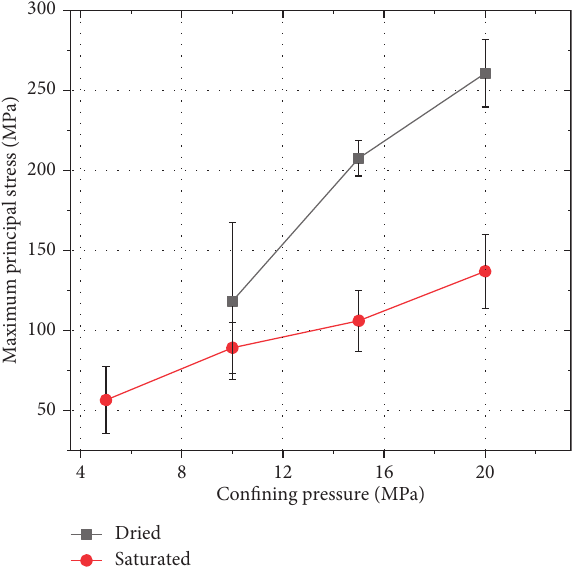
Figure 8: Variation of maximum principal stress with confining pressure in the triaxial